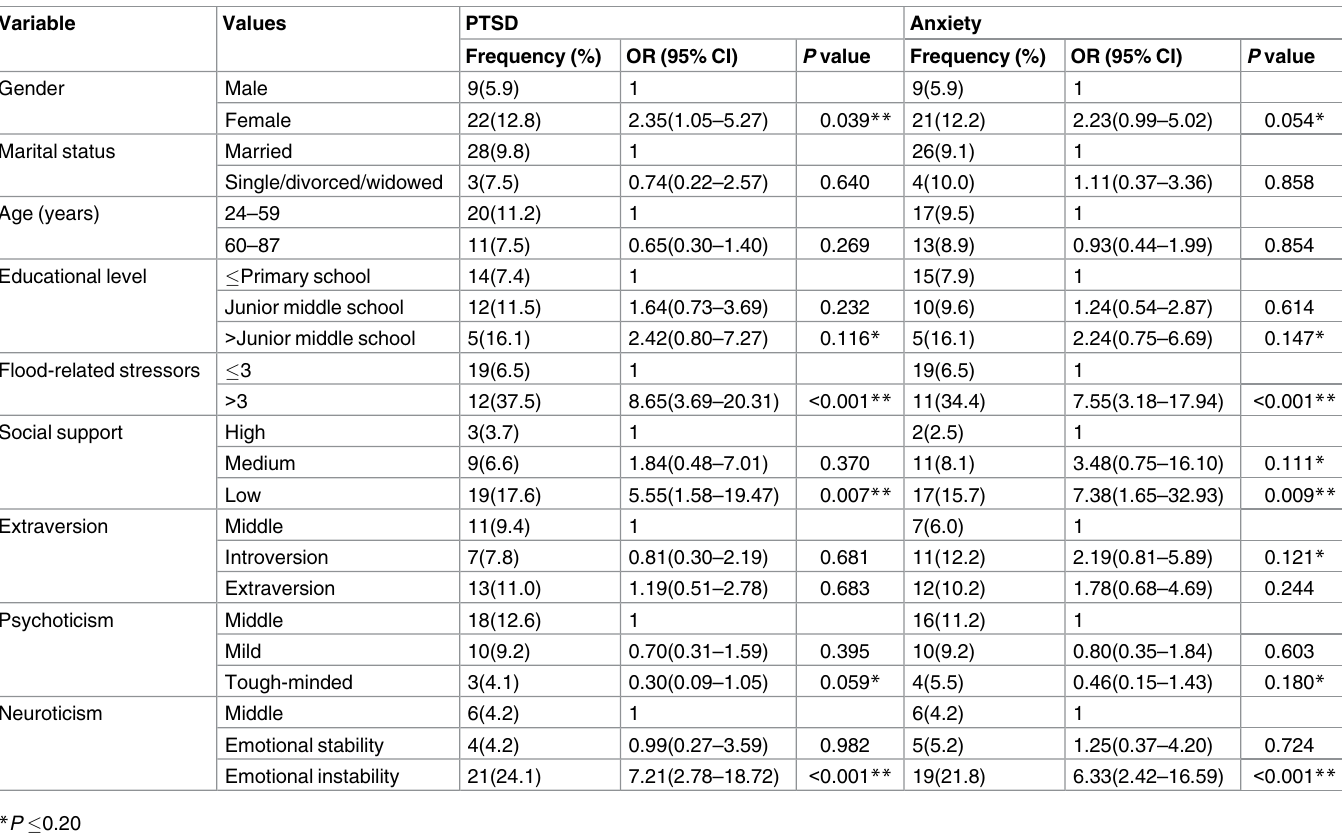
Table 2. Univariable logistic regression analyses of the effects of socio-demographic characteristics, flood-related stressors,social support and personality traits on the odds of PTSD and anxiety.